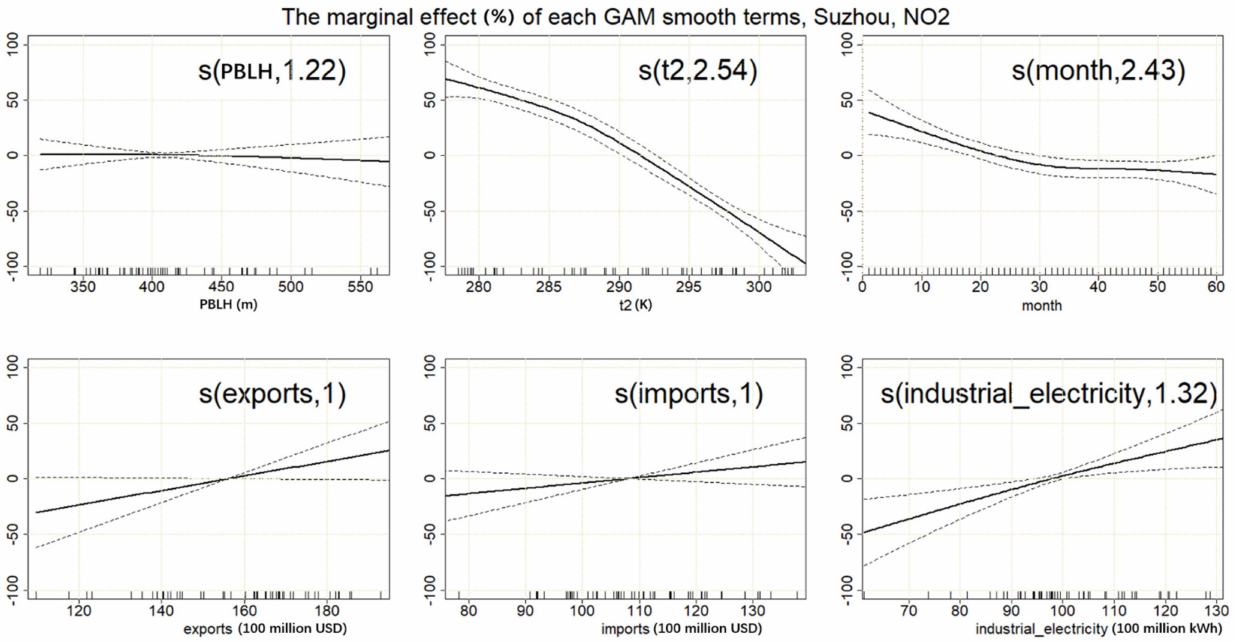
Figure 6. The marginal effect (%) of each GAM smooth term on NO 2 pollution of Suzhou. The response curves of pblh, t2, month, t2, exports, imports, and industrial electricity are shown in separate